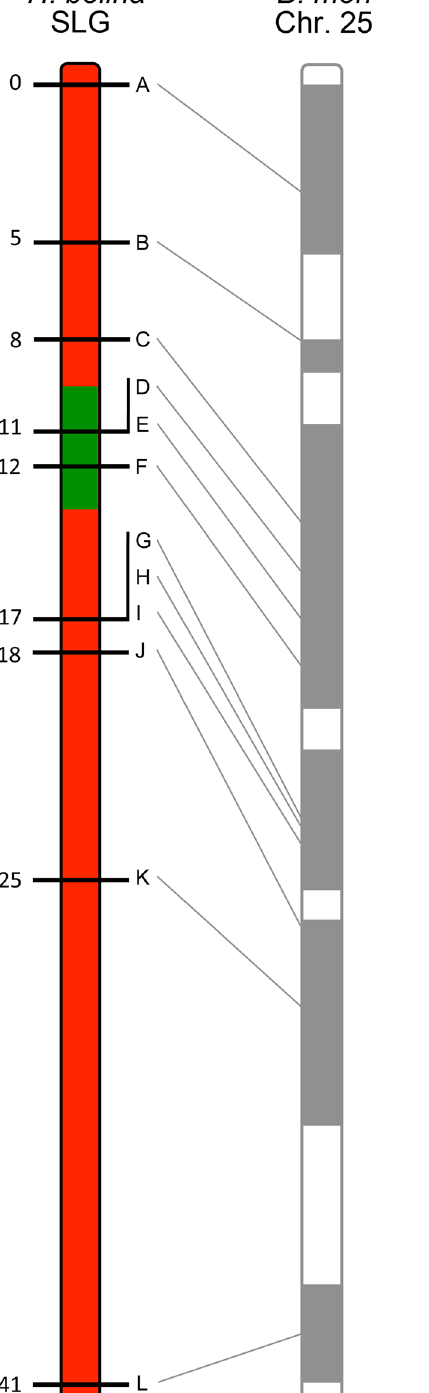
Figure 1. Recombinational map of the H.bolina chromosome carrying the suppressor locus. Depiction of the suppressor linkage group (SLG), with the 12 linked markers A-L. The genomic region containing the suppressor locus is highlighted in green. Numbers represent distance from the distal marker in cM as estimated using JoinMap. The broadly syntenic B. mori chromosome 25 is given